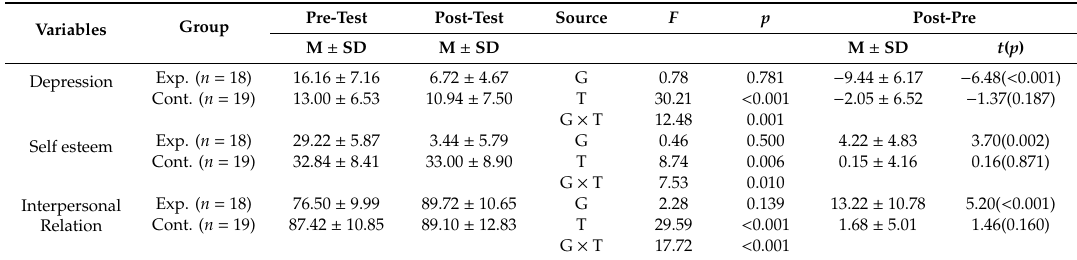
Table 3. E ff ects of the cognitive behavioral group program on the dependent variables between the experimental and control groups ( N =